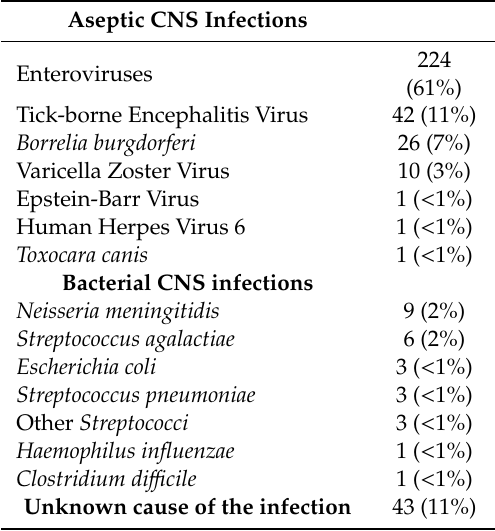
Table 2. Etiology of CNS infections in Polish